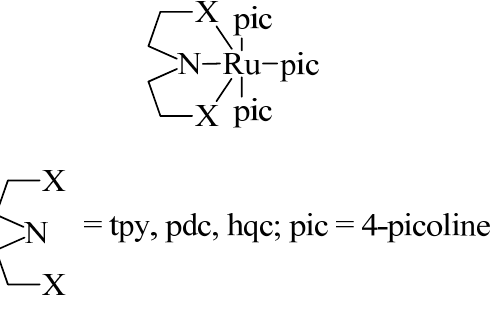
Figure 11. Mononuclear ruthenium water oxidation catalyst (WOC)